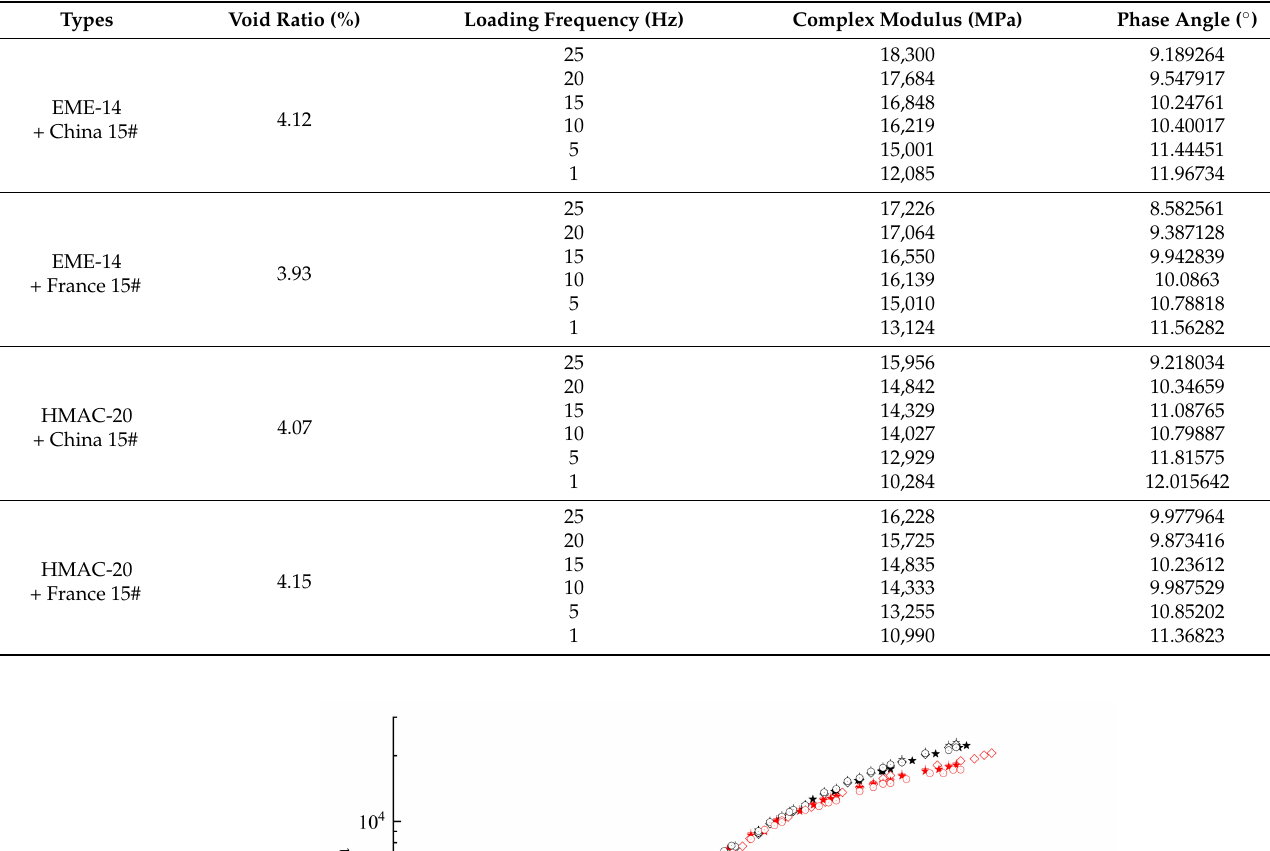
Table 10. Complex modulus results of different types of low-mark high-modulus mixtures at 15 ◦ C.